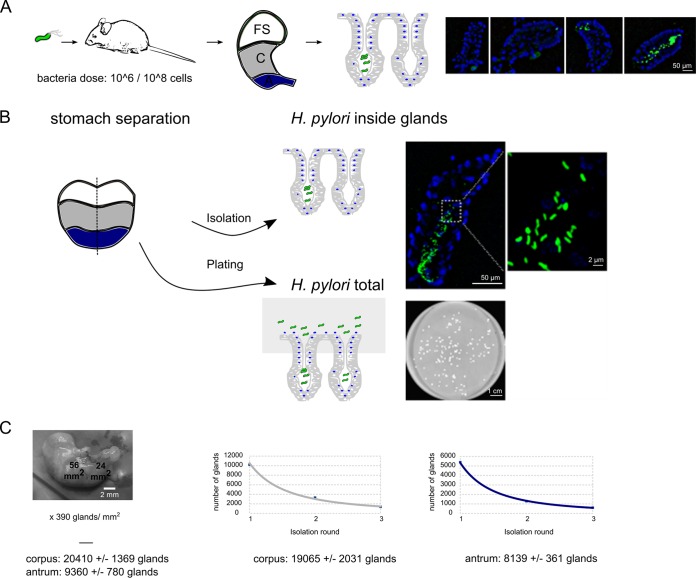
Methodology for gland isolation and quantification of bacteria and glands (A) The BLIG gland isolation method. (Left) The mice were infected with fluorescently labeled H. pylori strains. (Middle) The stomachs were isolated and separated (fore stomach [FS], corpus [C], and antrum). (Right) Glands with bacteria inside were isolated. Strain SS1 was chosen because it colonizes to high levels and is genetically stable over the course of infection. Bacteria were visualized by GFP expression (green), while gland cells were visualized using a DNA Hoechst stain (blue). Isolated glands displaying a range of different bacterial colonization levels are shown in the series of photographs, which show from left to right, empty glands to low and high colonization. (B) Overall protocol in which stomachs were isolated from infected mice and separated into two corpus pieces and two antrum pieces. One piece from the corpus and one piece from the antrum were homogenized and plated to obtain the total CFUs; the second pieces were used for BLIG gland isolation. Bacterial numbers were determined using microscopy. (C) Glands in the corpus and antrum were quantified by two methods. (Left) The area of antrum and corpus tissue of mouse stomachs was measured, and the total number of glands was calculated using the previously determined gland density of 390 glands/mm2 (35), multiplied by the area. (Right) The glands were isolated from antrum and corpus tissue in three sequential rounds, and the total numbers of glands were extrapolated from the decreasing gland numbers counted in the isolation process.